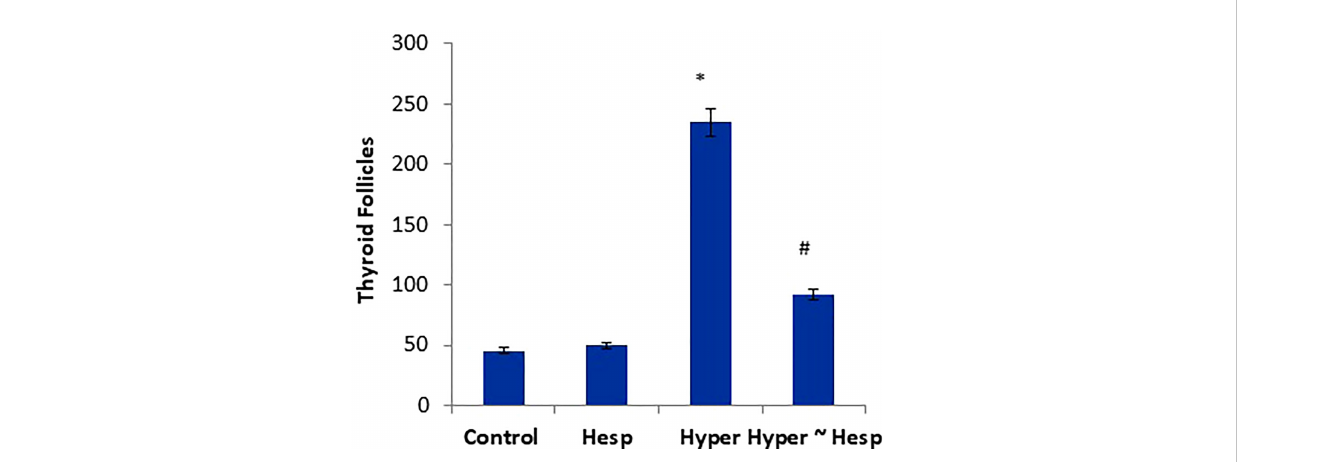
FIGURE 3 Scoring of thyroid follicles of healthy and hyperthyroidism treated animals ’ groups as compared to control group. Data are presented as mean ± standard error and they were subjected to one-way ANOVA followed by post-hoc test (Duncan) at p ≤ 0.05. Symbol * is signi fi cantly different from control group, while symbol # is signi fi cantly different from hyperthyroidism group.